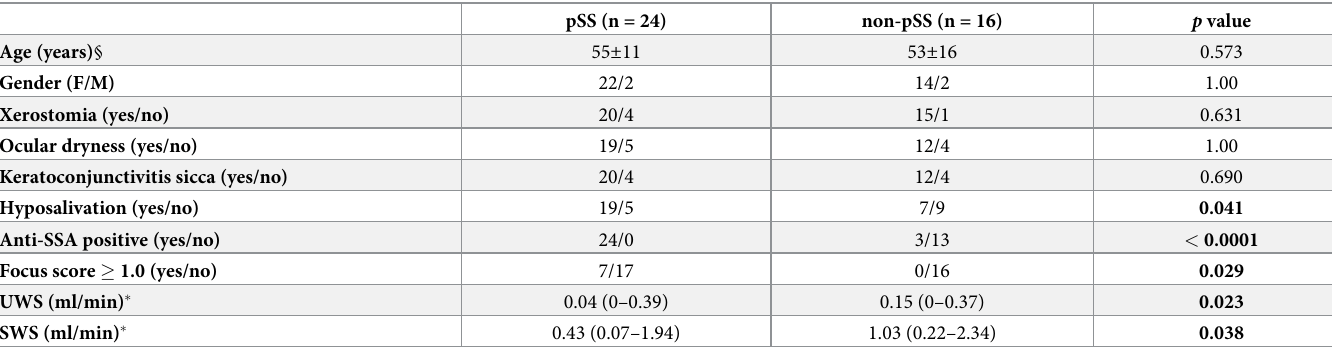
Table 1. Demographic and clinical data based on groups